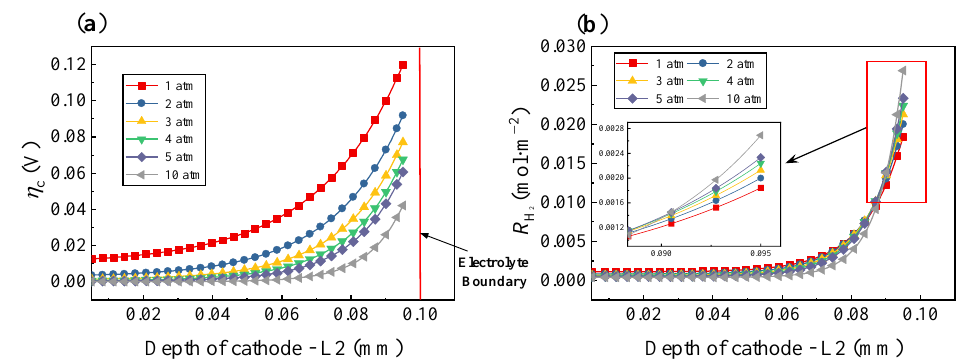
Figure 5. The effect of operating pressure on: ( a ) overpotential of cathode at L2; ( b ) hydrogen generation rate at L2.